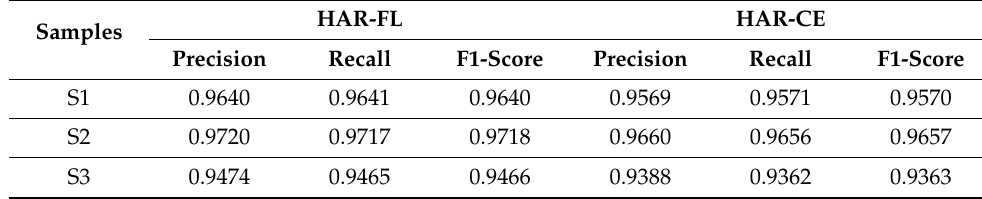
Table 10. The comparison results of HAR-CE and HAR-FL with D H data set. HAR-FL Samples